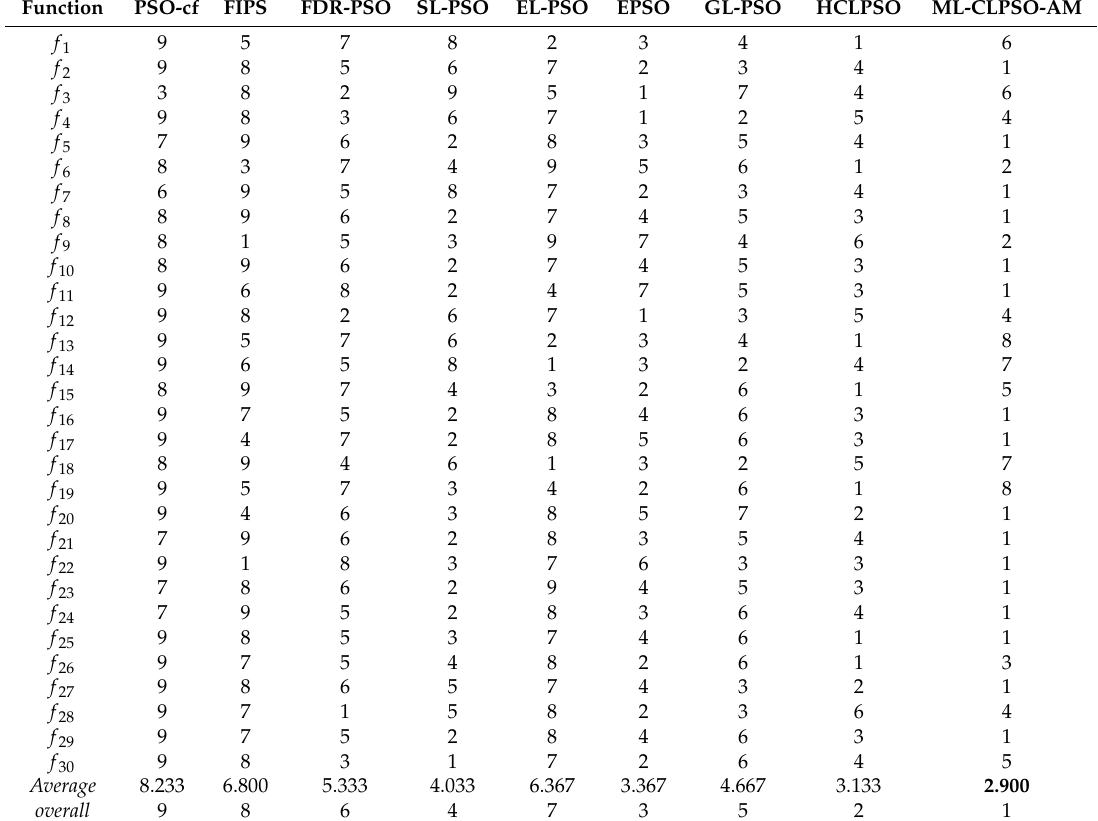
Table 4. Rank based analysis of mean performance among PSO